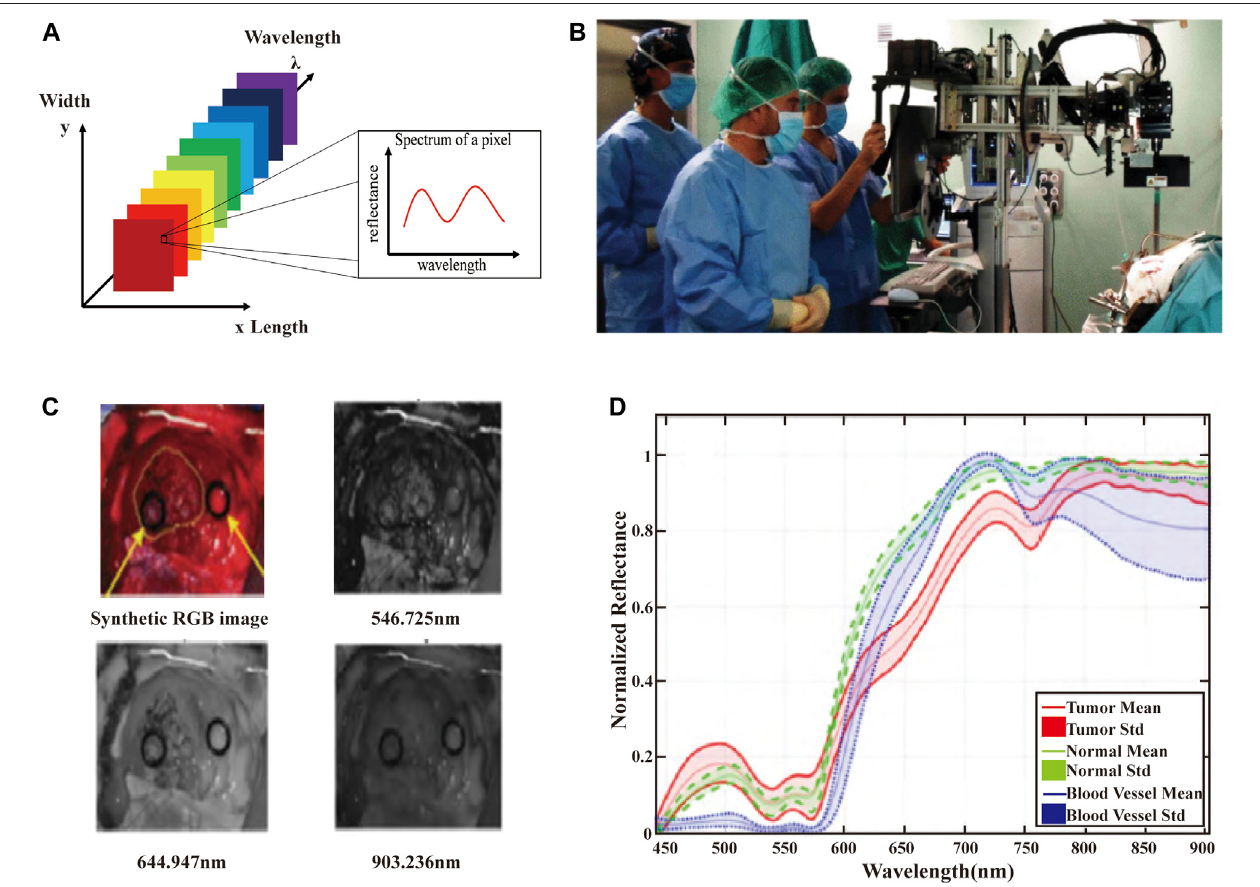
FIGURE 2 | (A) The schematic of the HSI data cube. The data measured in the HSI is presented by means of data cubes. Each slice of the data cube includes an imageofthesceneataspeci fi cwavelength.Eachpixelisassociatedwithaspectralresponsevector,alsoknownasaspectralfeature. (B) HSIacquisitionsystemusedin cerebral diagnosis applications. (C) Images at different wavelengths obtained from the brain HSI data cubes. (D) Spectral feature information of several brain tumor tissues in the VNIR range at the pixel of ROI (Fabelo et al., 2019a).